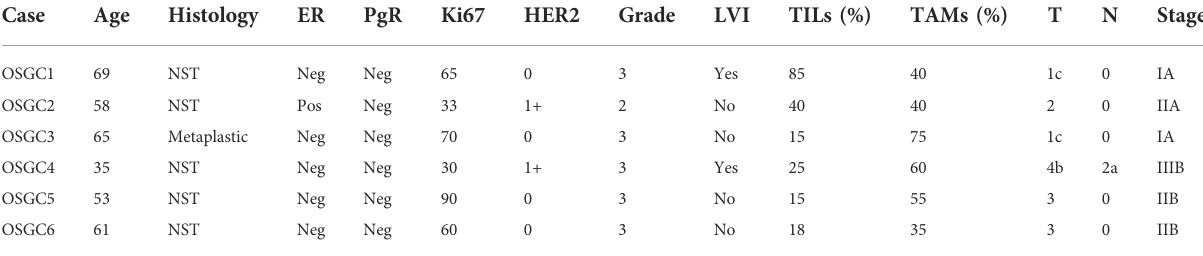
TABLE 2 Clinicopathological features of breast carcinomas with OSGC.